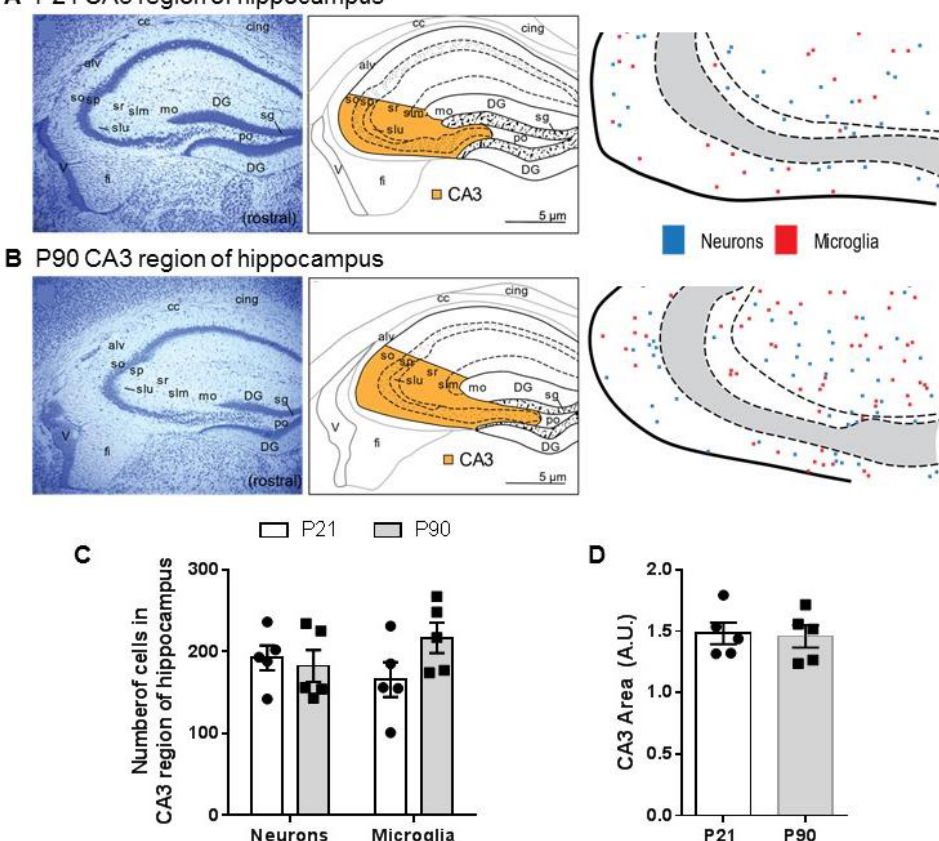
Figure 3. Juvenile and adult mice have a comparable number of neurons and microglia in CA3 region of hippocampus. Representative section of hippocampus with thionin stain, accompanied by maps from Allen Brain Atlas highlighting CA3 region, and traces of CA3 region with marks indicating location of neurons and microglia in ( A ) juvenile mice (P21) and ( B ) adult mice (P90). ( C ) Summary data showing no difference in the number of neurons and microglia in CA3 region of hippocampus between juvenile and adult mice. ( D ) Summary data showing no difference in the total area of CA3 region of hippocampus between juvenile and adult mice. Data are mean ± S.E.M. n = 5/group (same mice as used in chronoamperometry recordings). Abbreviations: alv alveus; cc corpus callosum; cing cingulum; DG dentate gyrus; fi fimbria; mo molecular layer; po polymorph layer; sg granular layer; slm stratum lancunosum moleculare; slu stratum lucidem; so stratum oriens; sp pyramidal layer; sr stratum radiatum; v lateral ventricle.